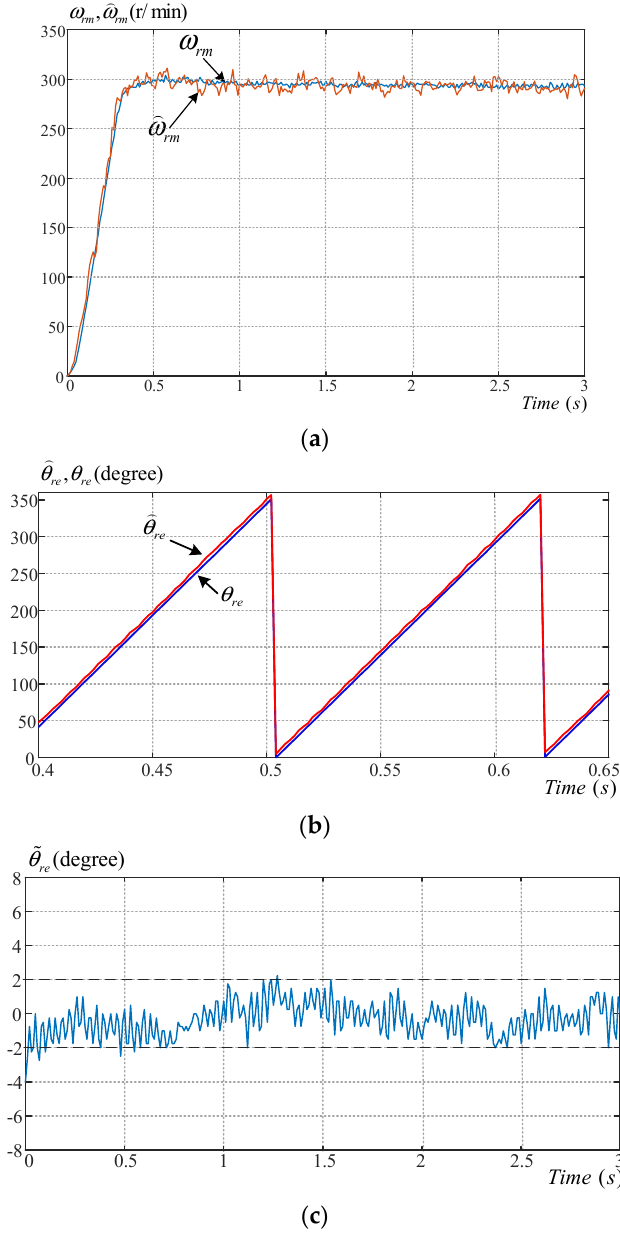
Figure 12. Measured speed and position responses using a multi-step speed predictive controller. ( a ) Speeds, ( b ) positions, and ( c ) errors of estimated position.